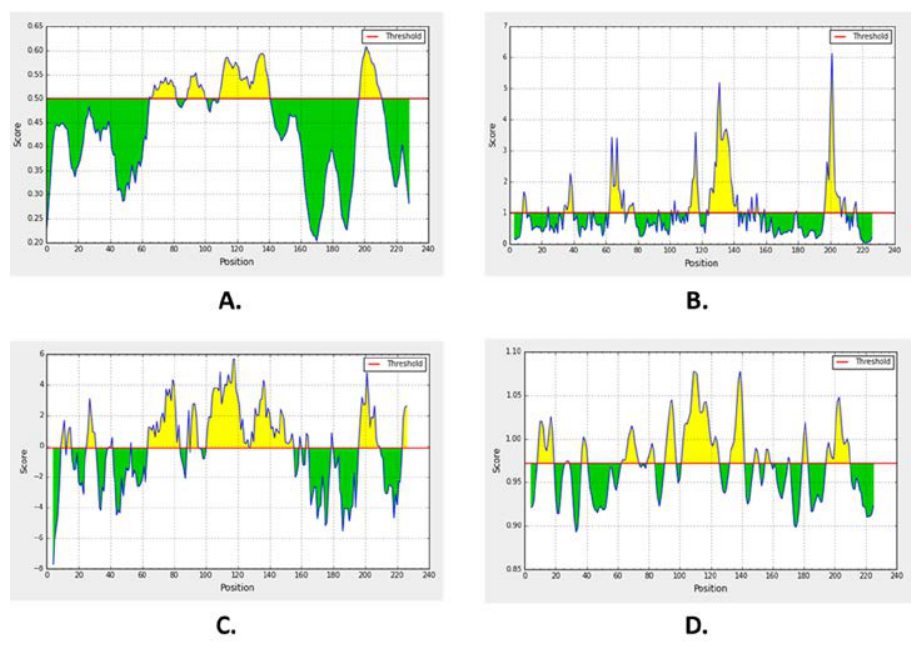
Fig. 3. The results of B-cell epitope prediction. Green areas showed negative prediction and yellow areas for positive prediction. (A) BepiPred; (B) Emini Surfaces Accessibility; (C) Parker Hydrophilicity; and (D) Karplus & Schulz